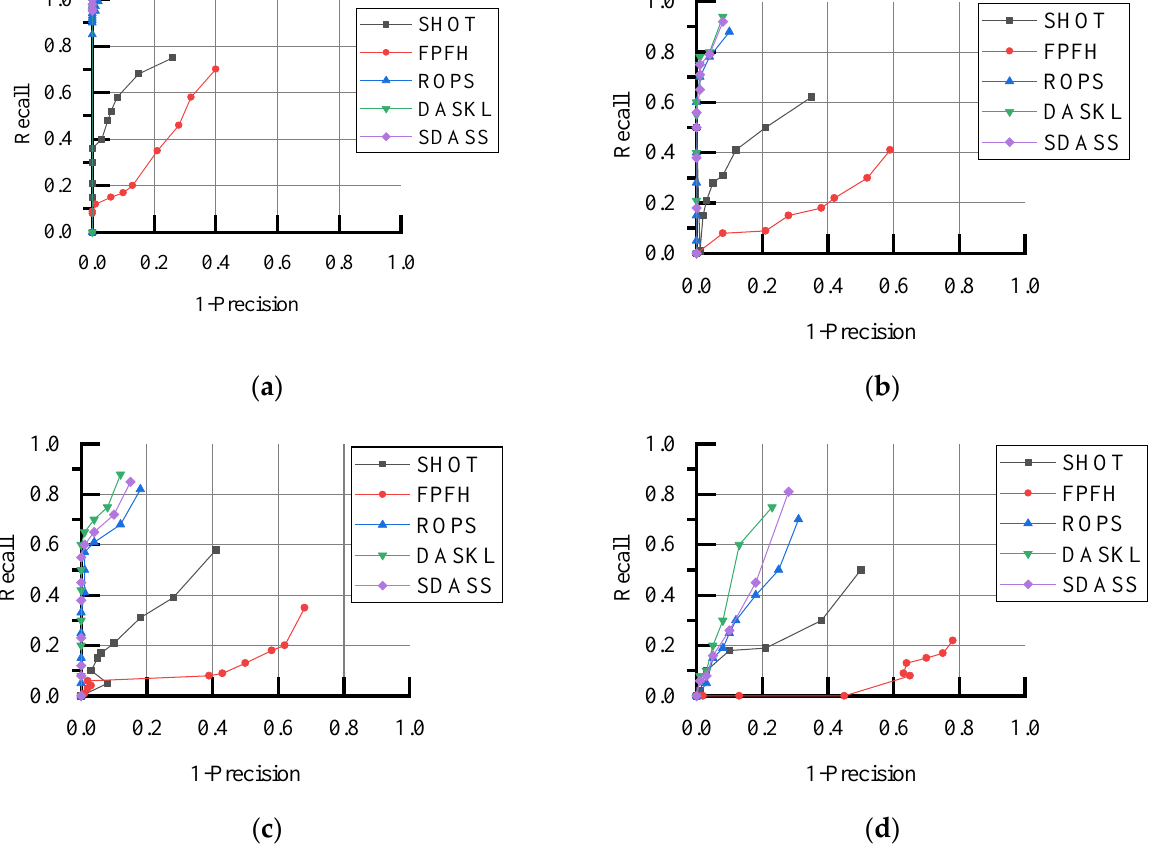
Figure 8. Comparison of feature matching performance with different downsampling levels ( a ) initial decimation.( b ) 1/2 decimation. ( c ) 1/4 decimation ( d ) 1/8 decimation.